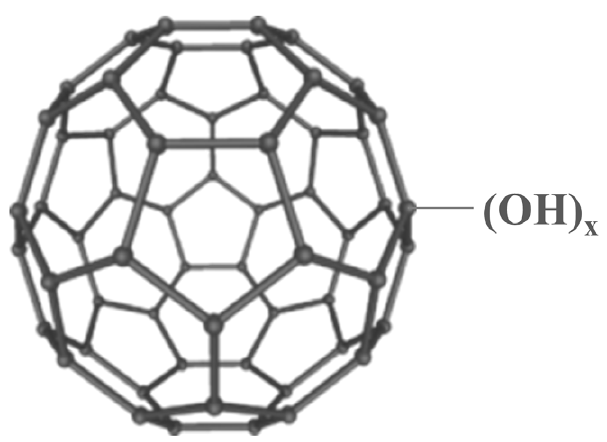
Figure 1. Chemical structure of a polydroxy fullerene (PHF) molecule (x=12 to 42).